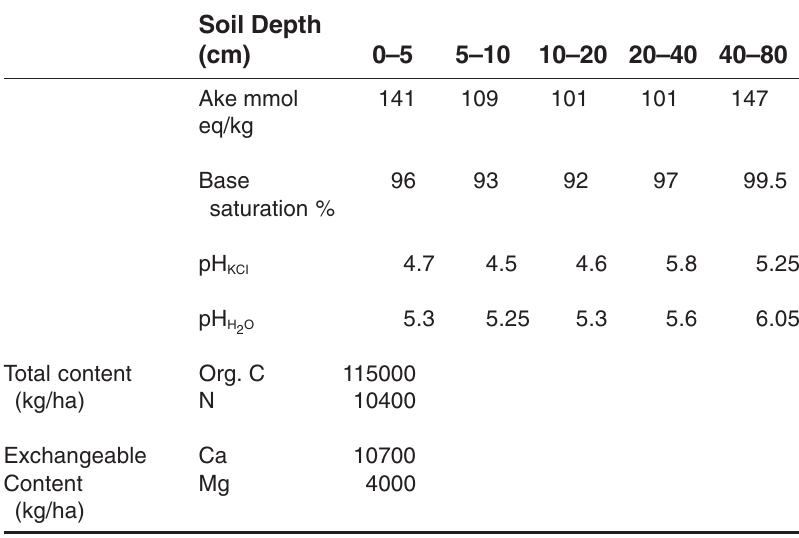
Zierenberg: Soil Chemistry, Mineral Soil (0 to 80 cm)